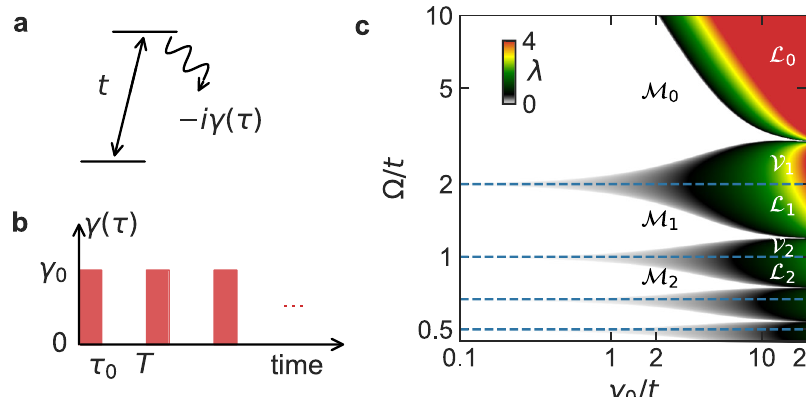
Fig. 1 PT phase diagram. a Schematic illustration of the dissipative two-level system under Hamiltonian (1). b The loss rate γ ð τ Þ in panel (a) is time-periodic with a square-wave modulation. The modulation period T ¼ 2 π = Ω ( Ω is the modulation frequency), and γ ð τ Þ ¼ γ 0 during the duty time interval ½ 0 ; τ 0 (cid:5) . c Theoretical phase diagram in the Ω (cid:2) γ 0 plane. Color contour shows the dimensionless parameter λ (see main text for de fi nition). Here we set τ 0 t = ð 2 π Þ ¼ 0 : 1 . Regions with vanishing λ correspond to the PTS phase ( M j ), while the colored regions ( L j and V j ) correspond to the PTB phase. The horizontal dashed lines indicate critical coupling frequencies separating the L j (quantum Zeno) and V j (quantum anti-Zeno) regimes.